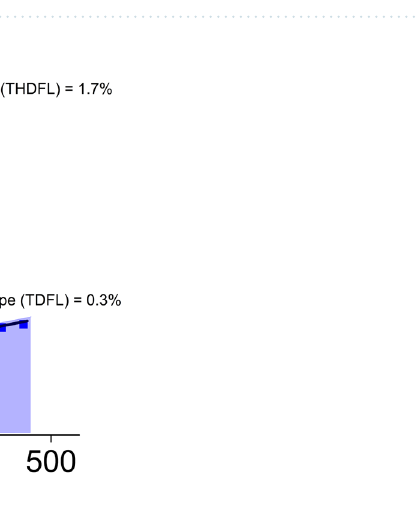
Figure 7. Mode-locked THDFL output at 397 mW. (a) Enlarged optical spectrum (Inset shows full soliton spectrum); (b) pulse train; (c) radio frequency (RF) spectrum (Inset shows RF spectrum over a wider span range of 400 MHz); and (d) autocorrelation trace.